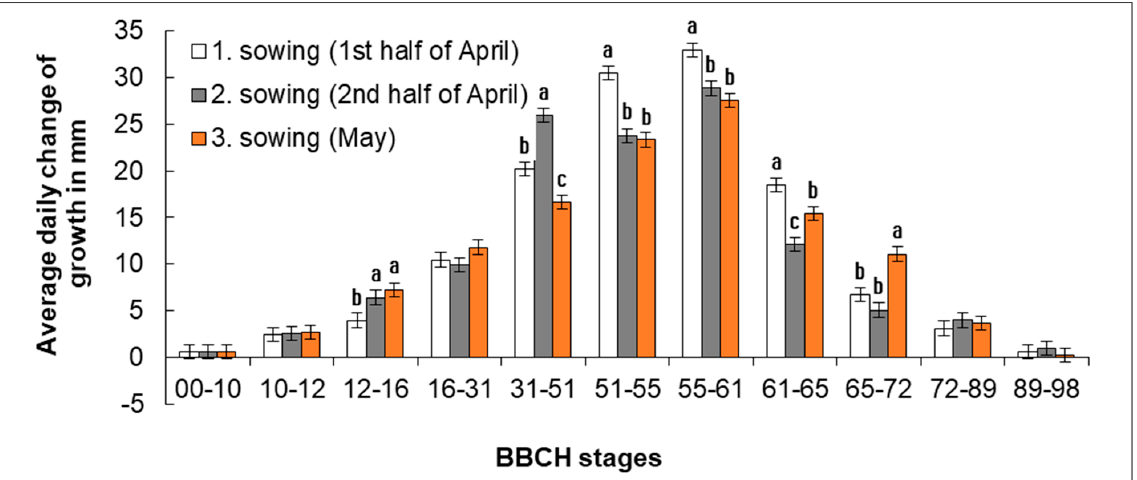
Figure 5. Effect of sowing date on average daily height increment reached between the respective developmental stages BBCH. Average values ( n = 90) of individual variants are shown for the specific range of BBCH developmental stages in three years of study ± SD. Different letter indices are added only to variants in which significant differences were found ( p < 0.05). If there are no letter indices, no significant differences were found between the individual variants.